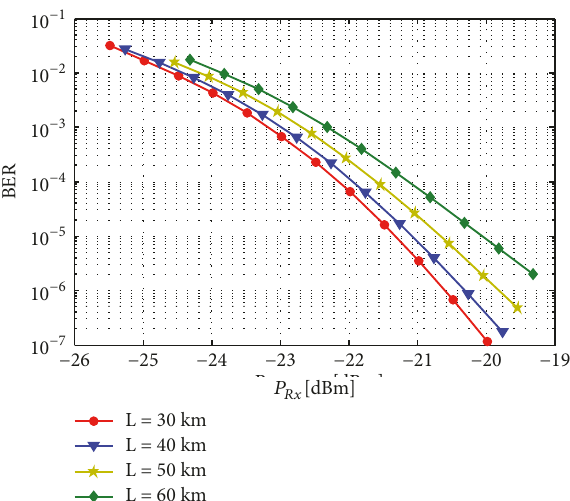
Figure 15: BER curves versus received power for different lengths (L = 50 km, (cid:2) 𝛼 PDL = 0.03 dB, (cid:2) 𝜗 = 5 ∘ , and f BR = 10 Gbit / s ) .